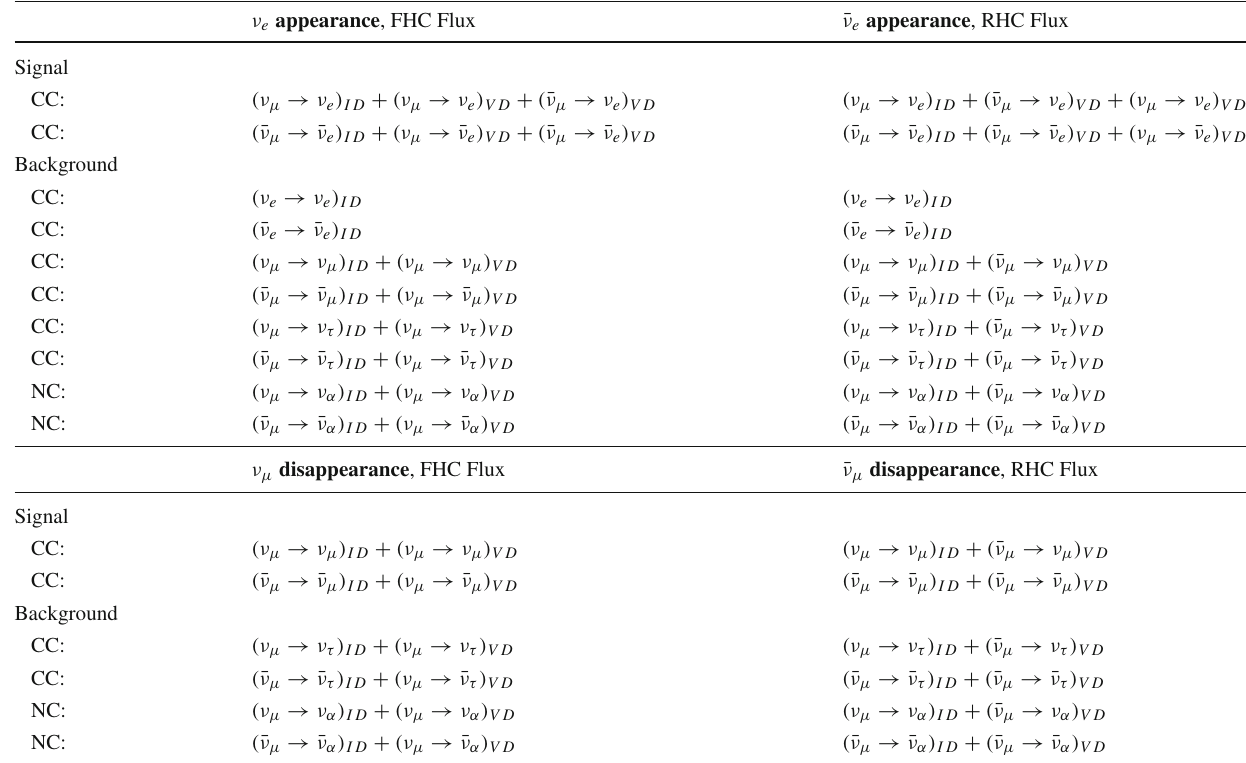
Table 1 AEDL rules for ν ( − ) e , ν ( + ) e appearance, and ν ( − ) μ , ν ( + ) μ disappearance. We denote ν α = ν ( − ) α and ¯ ν α = ν ( + ) α